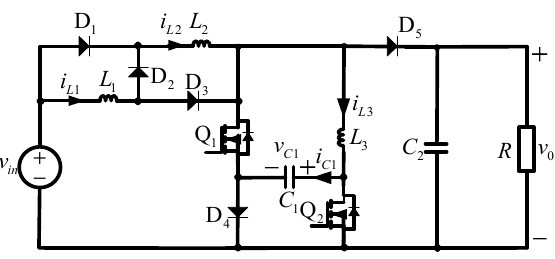
Figure 1 . Circuit schematic of the proposed step-up converter. Figure 1. Circuit schematic of the proposed step-up converter.